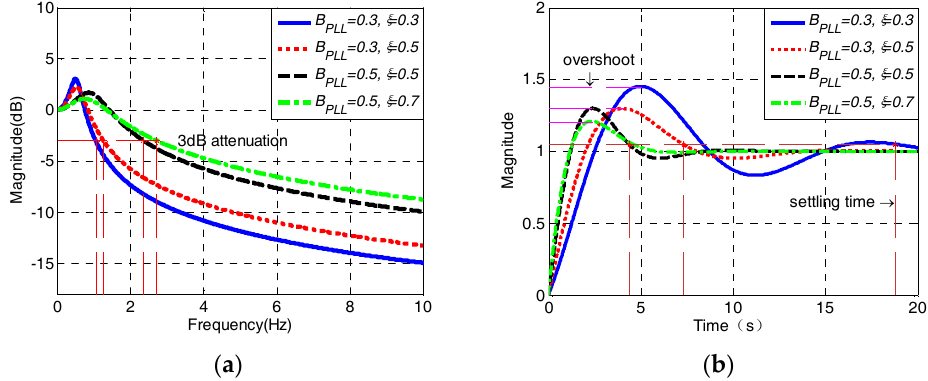
Figure 12. Amplitude–frequency ( a ) and step ( b ) responses of the second-order PLL.